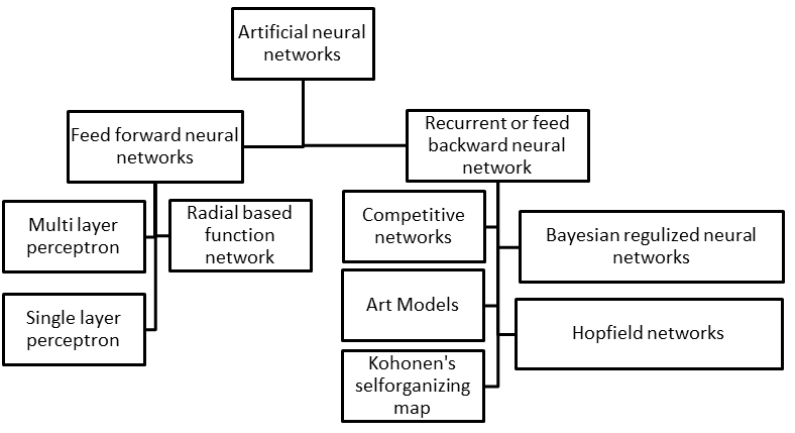
Figure 2. Artificial neural network